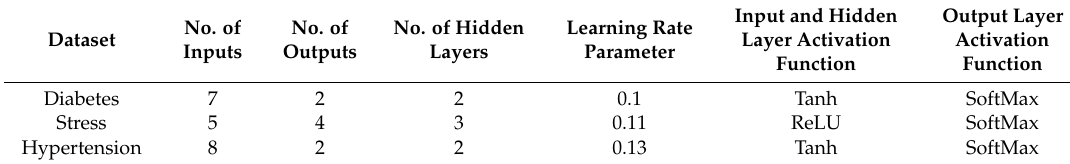
Table 4. Configuration of the deep neural network.